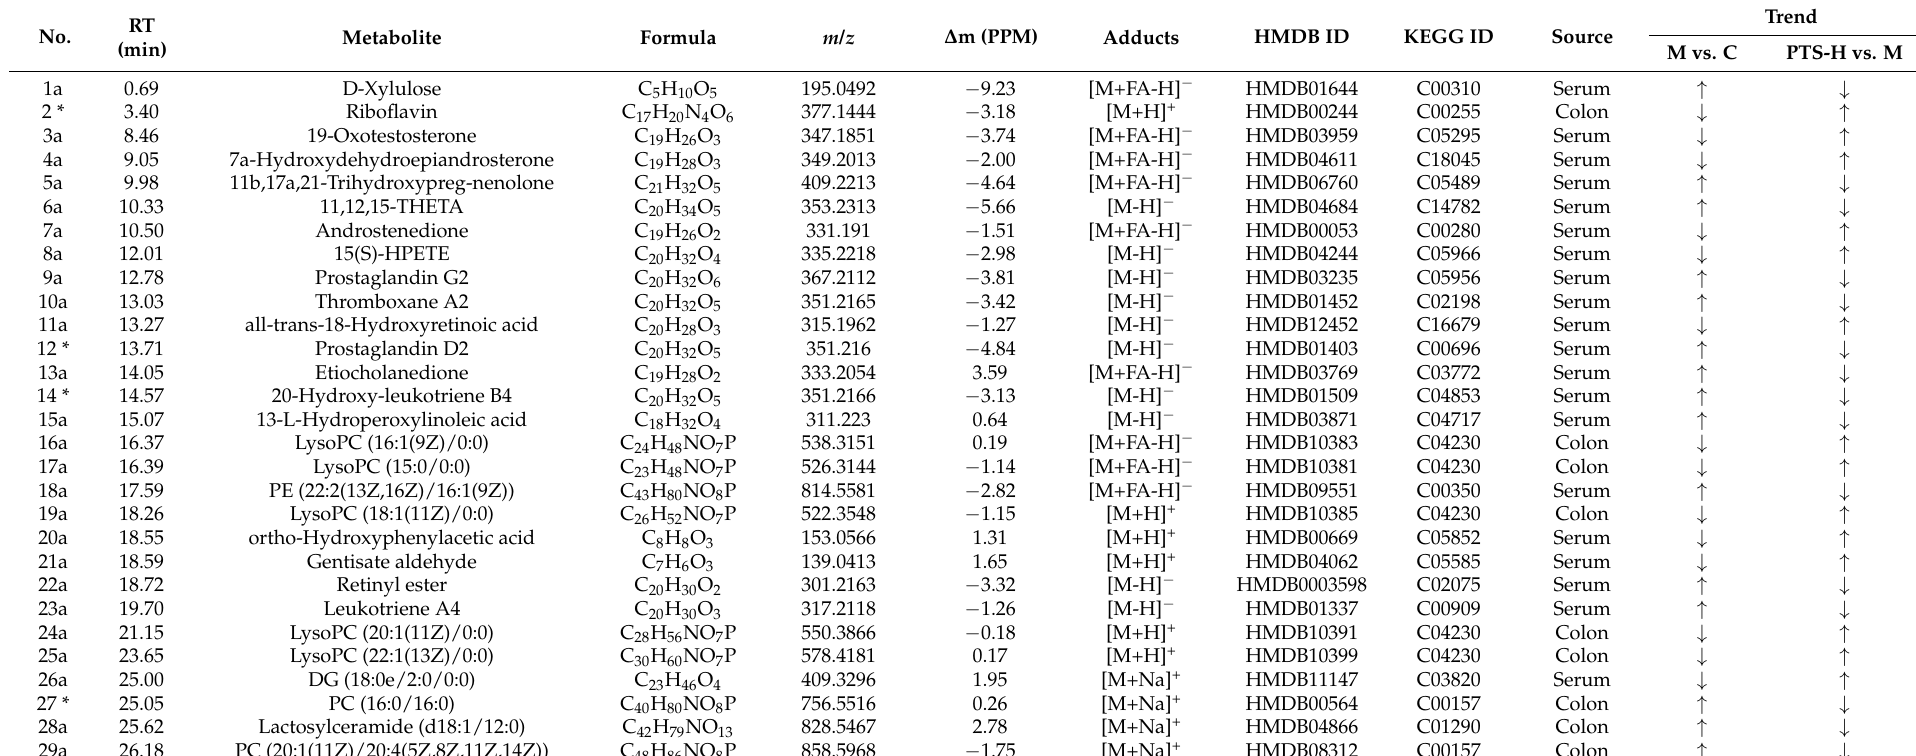
Table 2. Endogenous metabolites identified in DSS-induced ulcer colitis mouse serum and colon that were regulated by